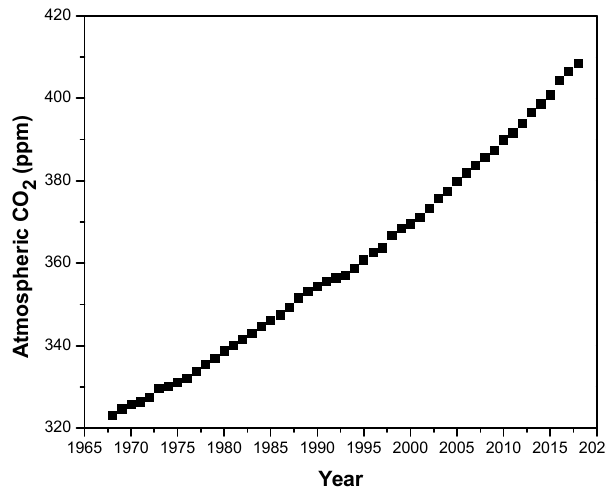
Figure 1. Atmospheric CO 2 concentration (ppm) in the past 25 years.